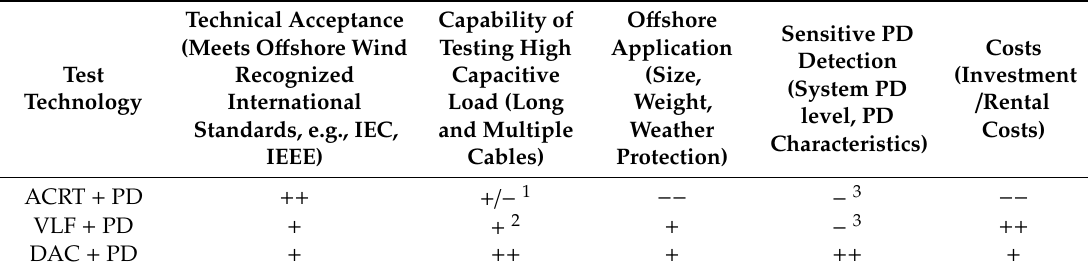
Table 1. Overview of test technologies for monitored withstand test of 66 kV subsea inter-array